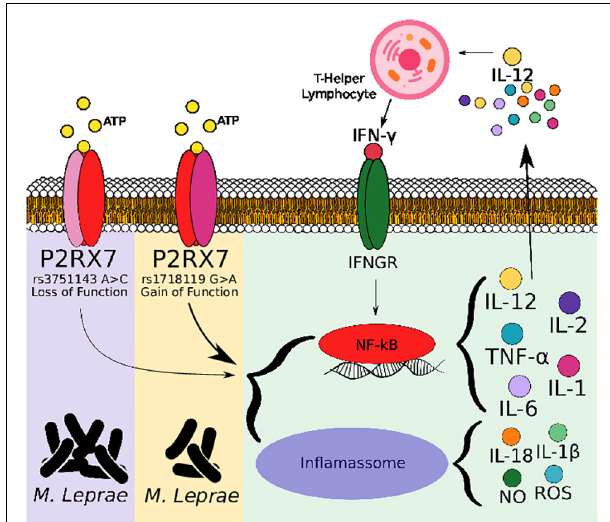
FIGURE 2 | Schematic hypothesis of Mycobacterium leprae elimination following ATP ligation of P2X7. M. leprae and extracellular ATP released during infection triggers P2X7 signaling cascade, which culminates in nuclear factor-kappa B translocation to nucleus, stimulating secretion of cytokines and chemokines, inducing recruitment of inflammatory cells and producing inflammatory mediators such as reactive oxygen species and nitric oxide, which can either direct stimulate mycobacteria elimination or activate NLR family pyrin domain containing three inflammasome for this elimination. P2X7 receptor’s loss-of-function polymorphism (rs3751143) have been linked to impaired capacity of macrophages to eliminate bacillus contrary to P2X7 receptor’s gain-of-function polymorphism